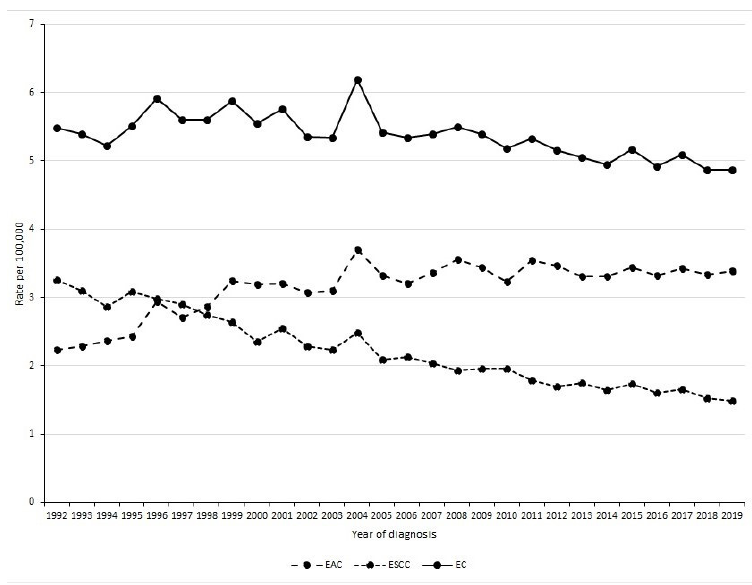
Figure 1. Time trends of age-standardized incidence rates for esophageal cancer (EC) overall, esophageal adenocarcinoma (EAC), and esophageal squamous cell carcinoma (ESCC).